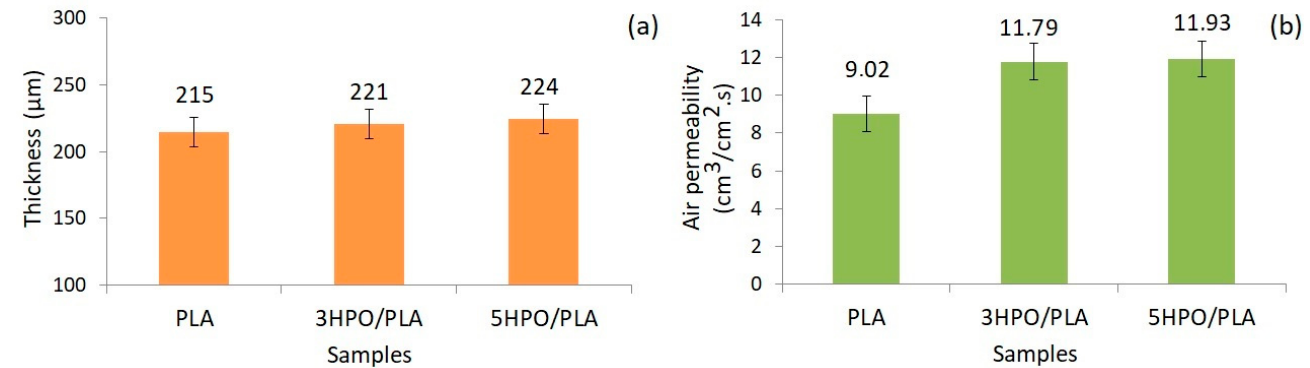
Figure 4. The thickness ( a ) and, air permeability ( b ) test results of PLA and HPO/PLA electrospun nonwoven fabrics.